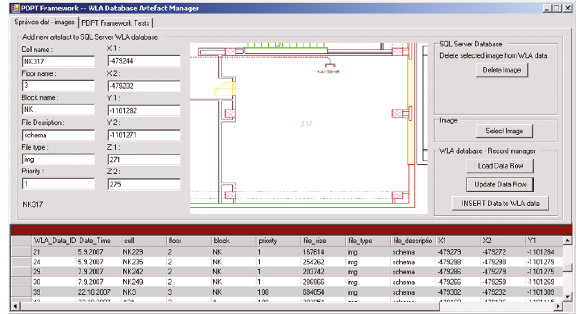
Figure 3: PDPT Framework Data Artefact Manager—this software substitutes a live connection to information system if it does not exist.